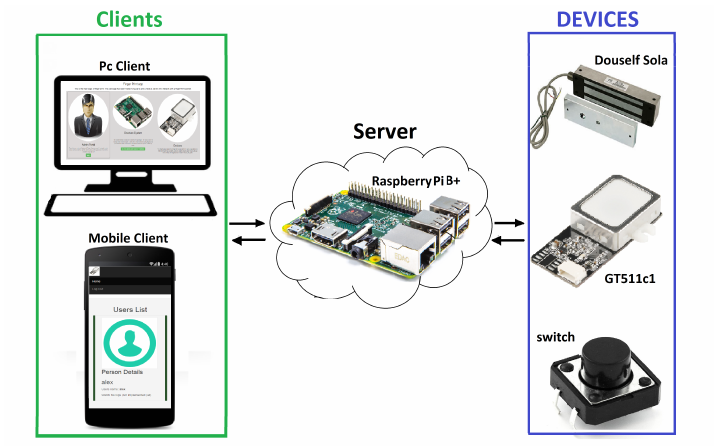
Figure 3. FingerScanner